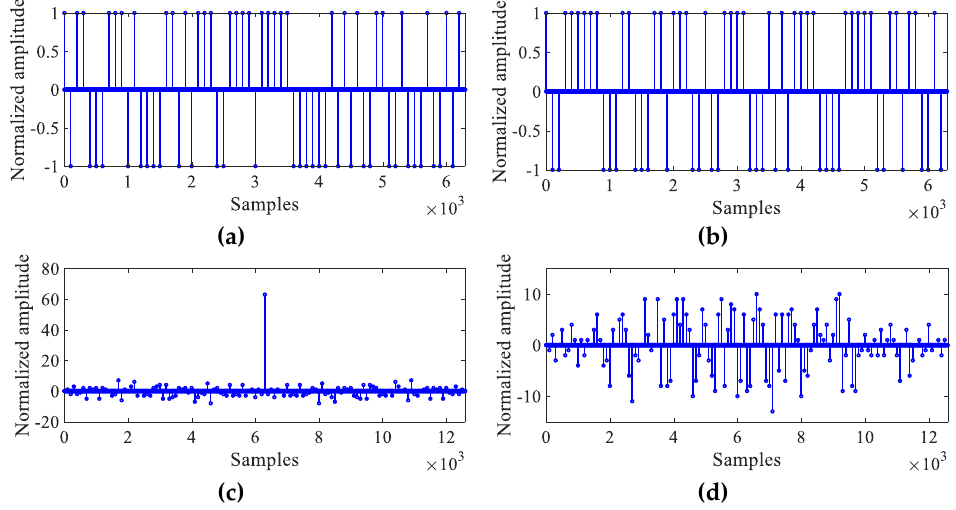
Figure 3. Kasami sequence analysis of ACF and CCF, ( a ) one 63 − bit Kasami sequence, ( b ) the other 63 − bit Kasami sequence, ( c ) and ( d ) the corresponding ACF and CCF. Table 1. Kasami sequences used in this paper.